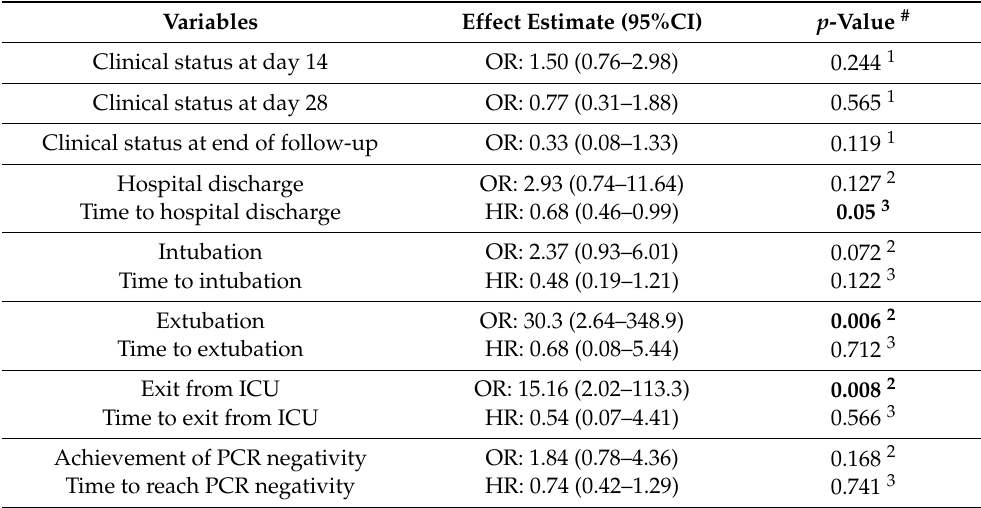
Table 5. Results of univariate regression analyses for the association between the convalescent plasma infusion and secondary